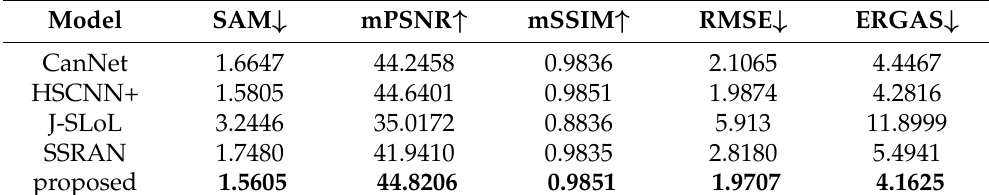
Table 4. Quantitative results of different methods on ZY1-02D dataset. “ ↓ ” means smaller is better for this index. “ ↑ ” means bigger is better for this index.